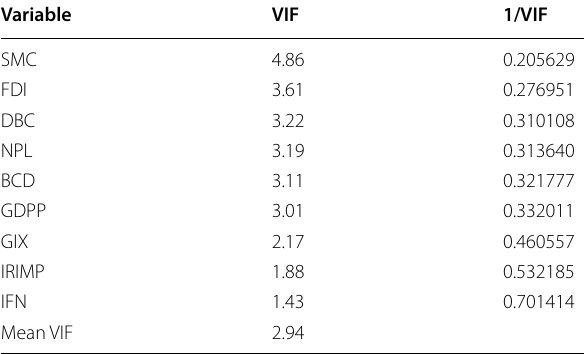
Table 6 Multicollinearity